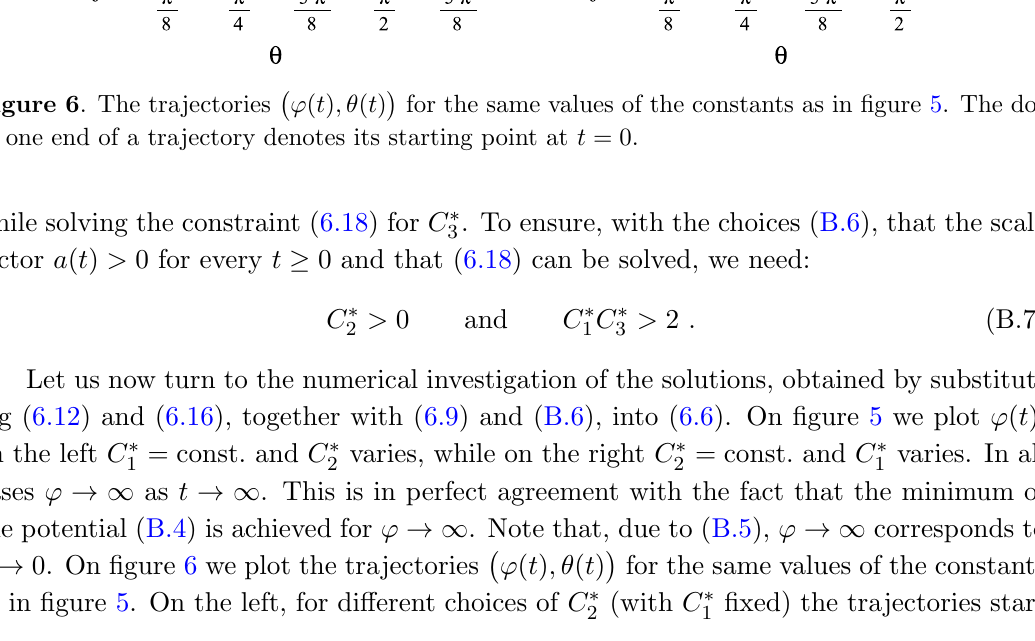
(cid:0) (cid:1) ’ ( t ) ; (cid:18) ( t ) for the same values of the constants as in (cid:12)gure 5. The dot